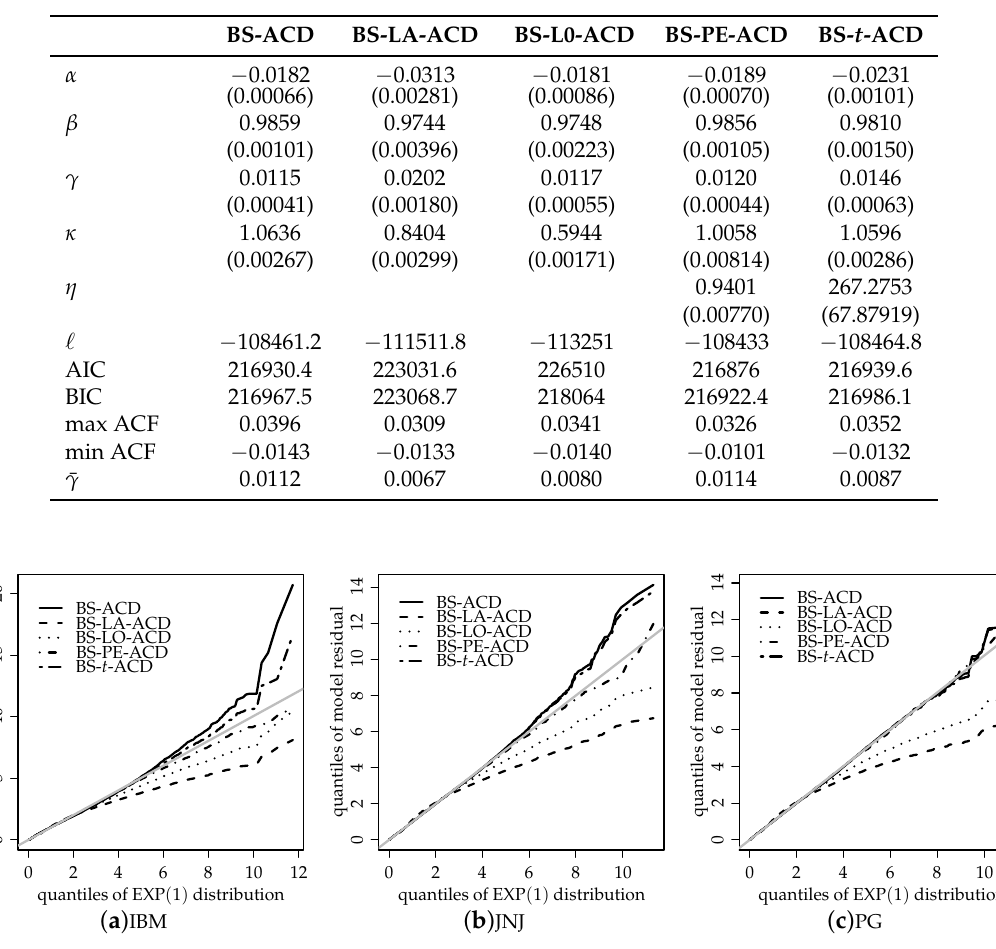
Table 6. Estimation results based on the GBS-ACD models for PG trade durations.